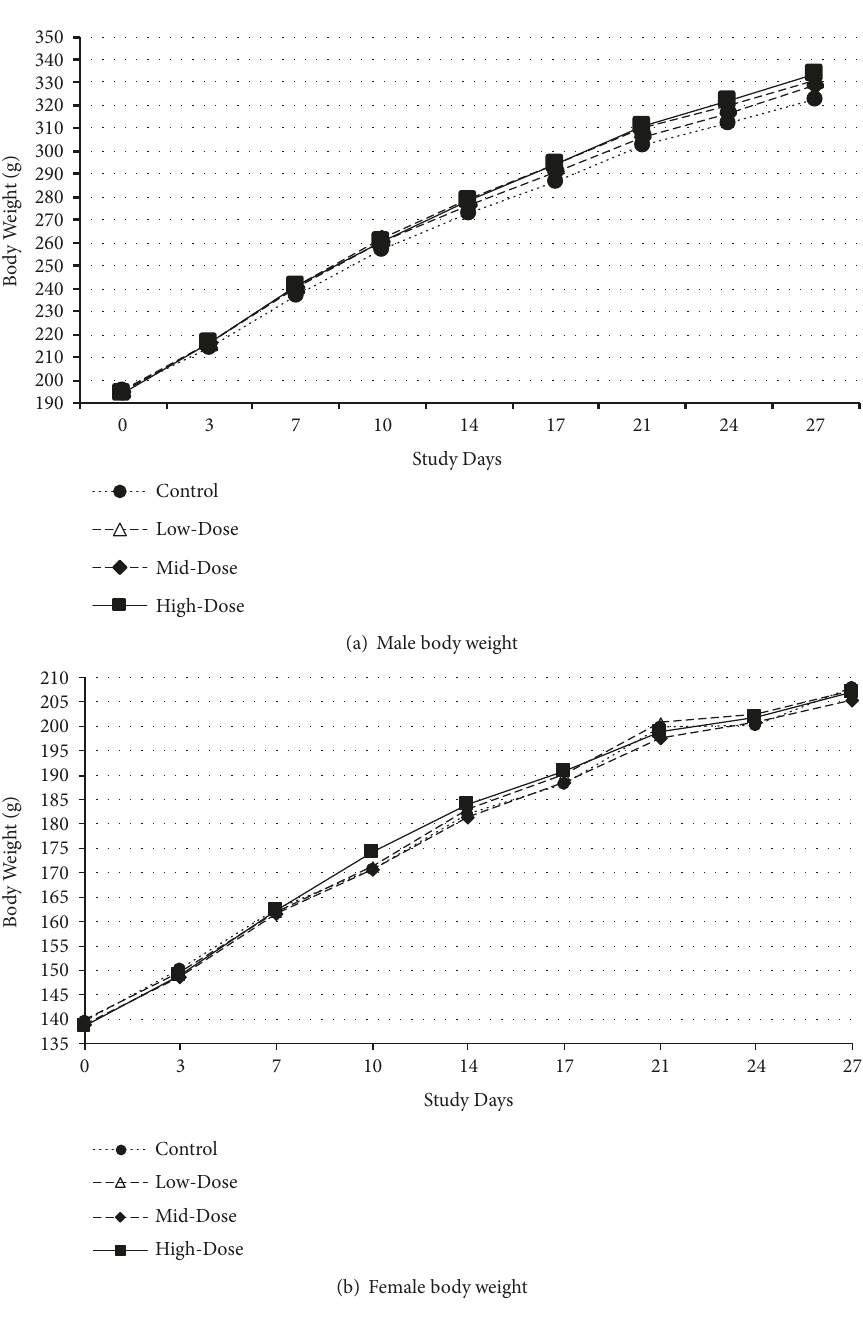
Figure 1: Body Weights in the 28-Day Study . Control = 0 mg/kg bw/day; low-dose = 400 mg/kg bw/day; mid-dose = 800 mg/kg bw/day; high-dose = 1200 mg/kg bw/day. (a) Male body weights. (b) Female body